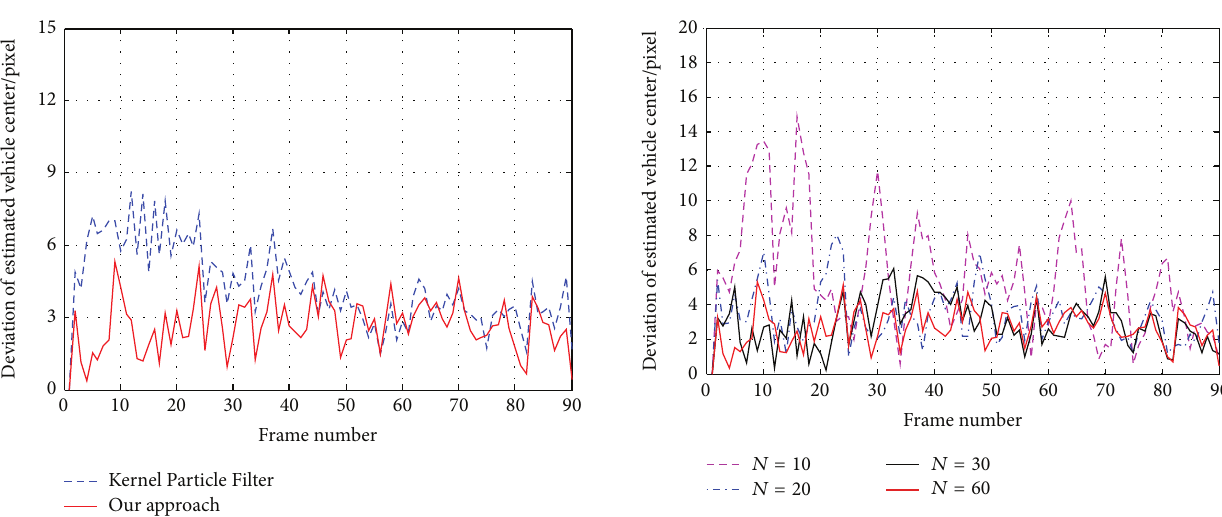
Figure 7: Comparison of the deviation in each frame with 60 particles.